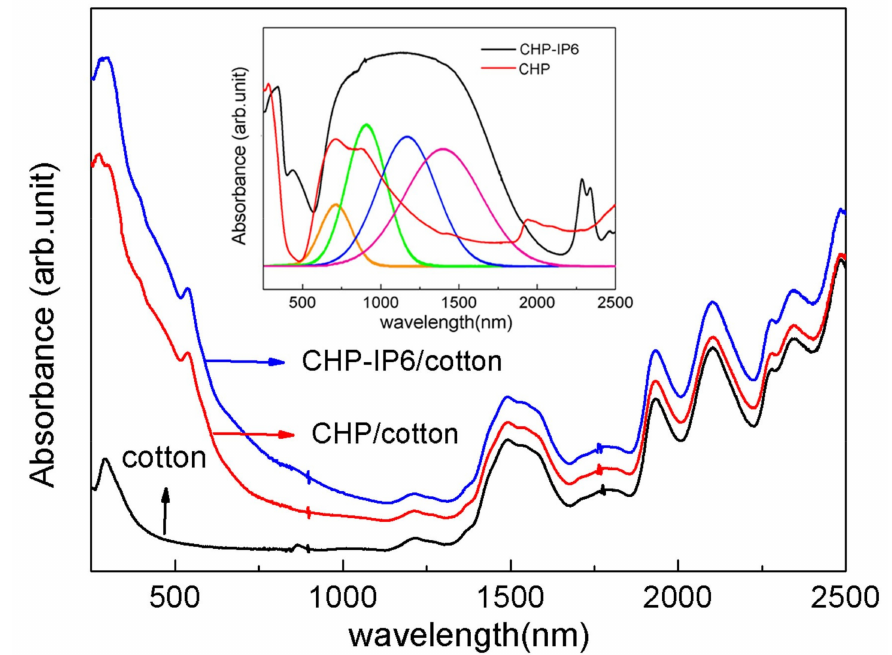
Figure 6. UV–VIS–NIR diffuse reflectance spectra of pristine cotton and coated cotton